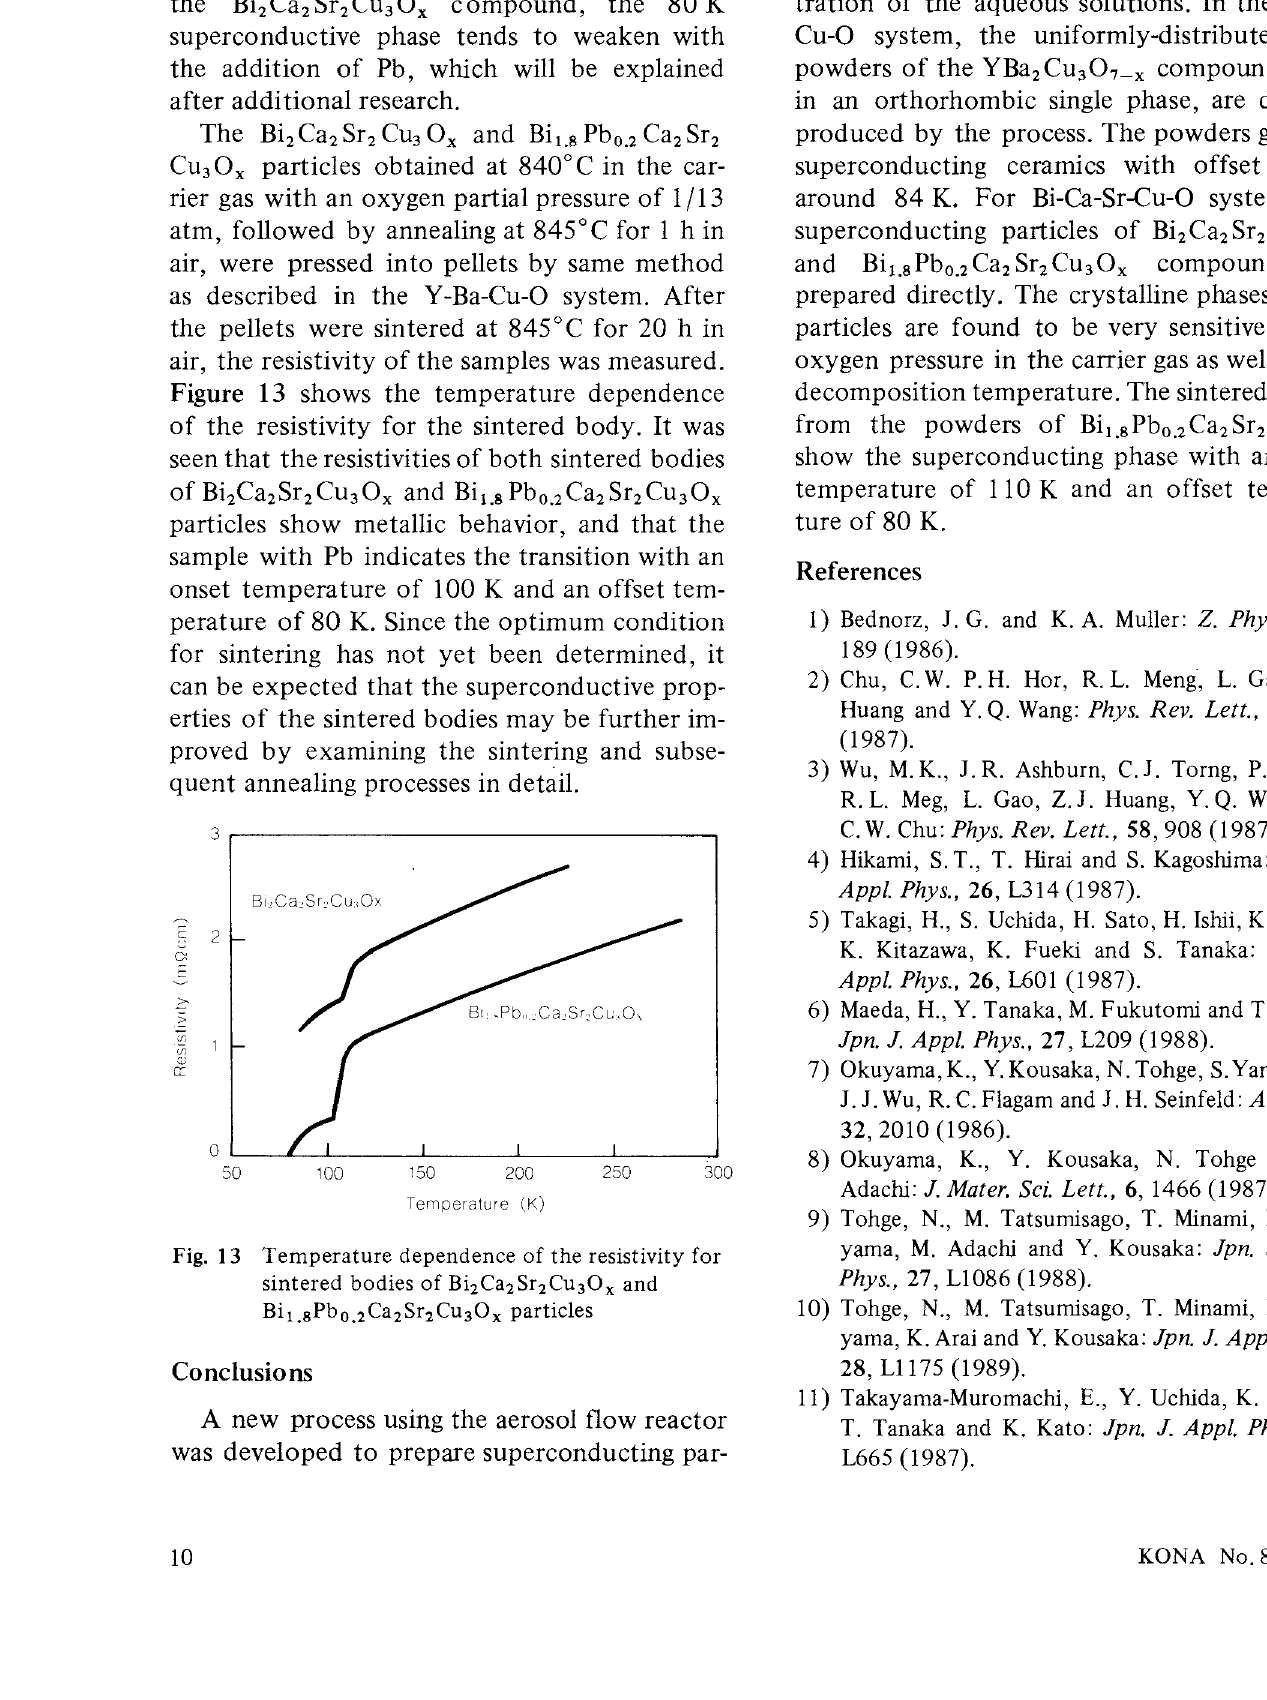
Fig. 13 Temperature dependence of the resistivity for sintered bodies of Bi CazSr 2 Cu30x and 2 Bi1. Pb 0•2 Ca Sr Cu30x 2 8 2